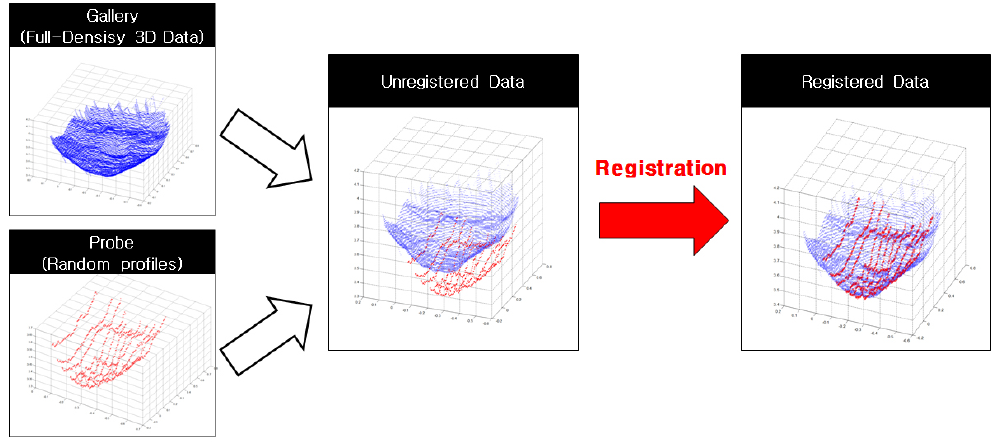
Figure 10. Registration between FD 3D face data and random